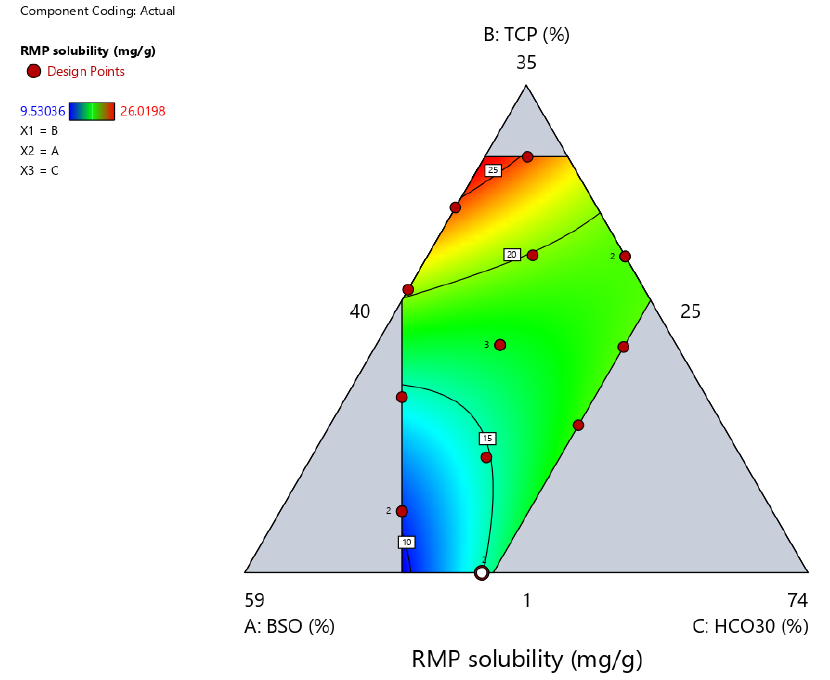
Figure 4. The contour representation of the effects of the formulation variables on RMP apparent solubility.